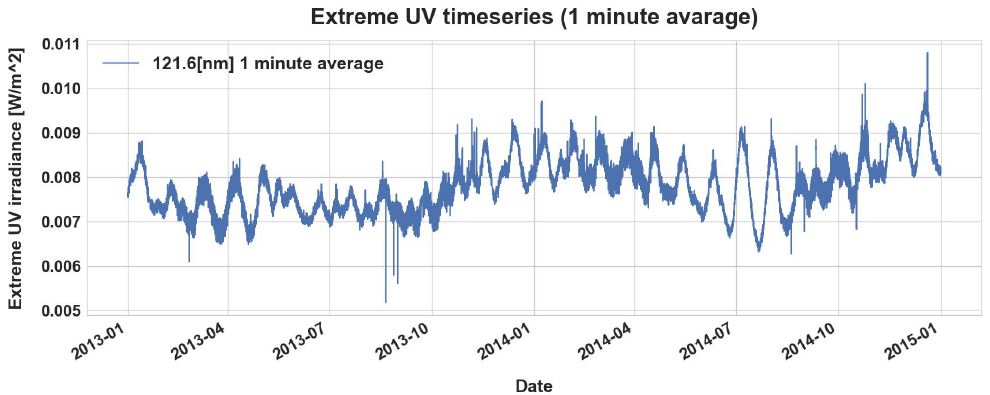
Figure 2. EUV irradiance acquired from GOES-15 Extreme Ultraviolet Sensors (EUVS) instrument, between years 2013 and